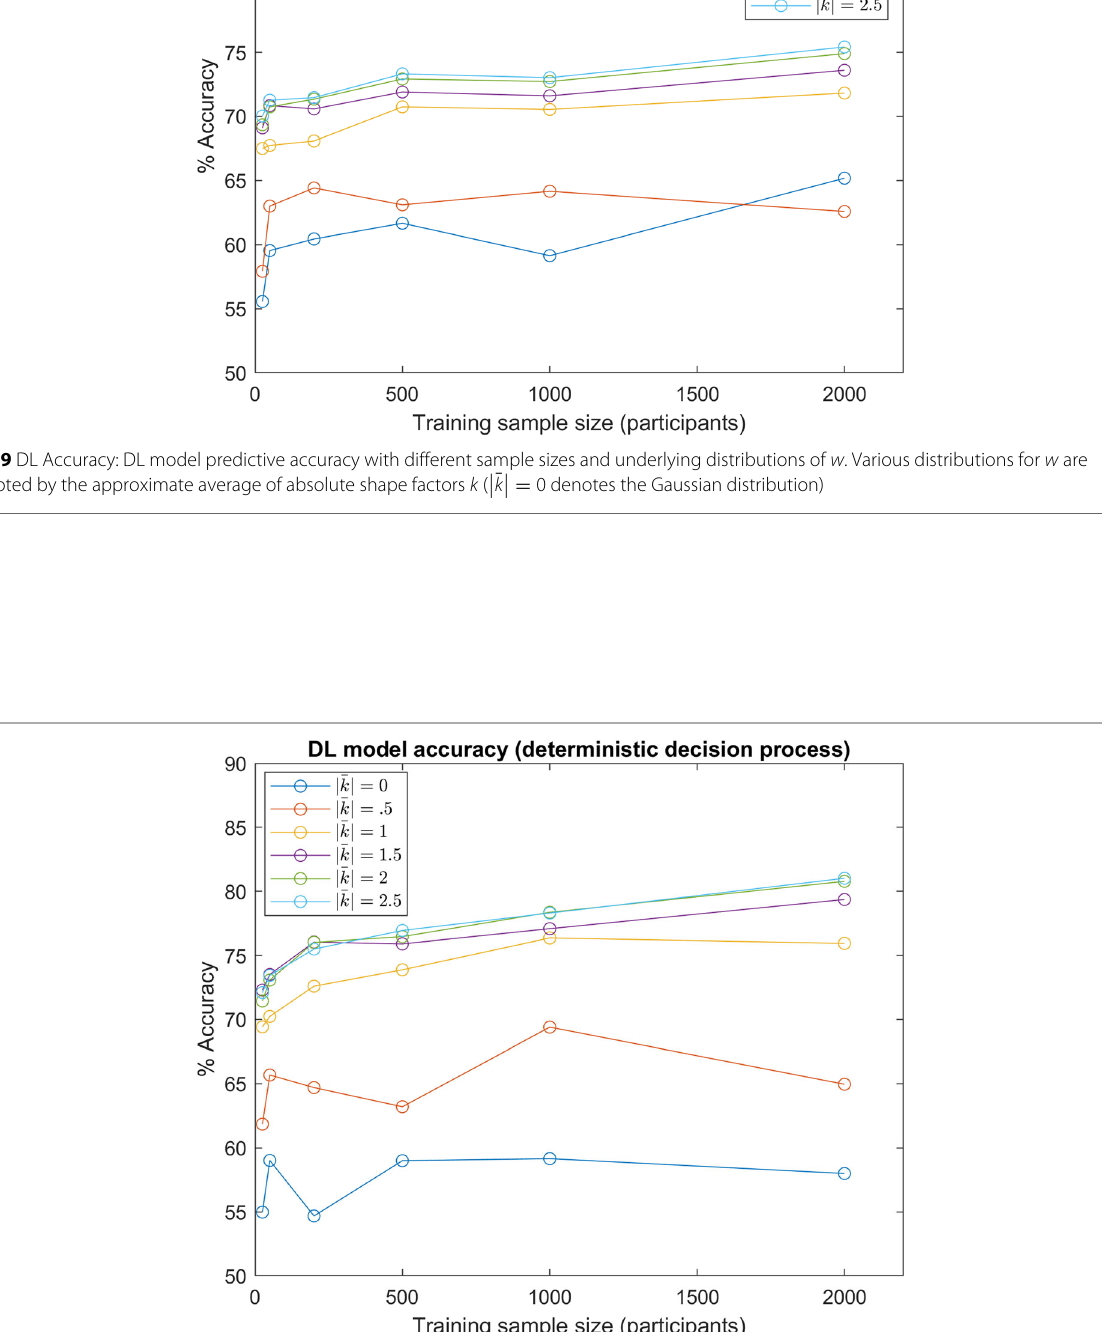
(cid:14) (cid:14) (cid:14) ¯ k (cid:14) = 0 denotes the Gaussian distribution) In this